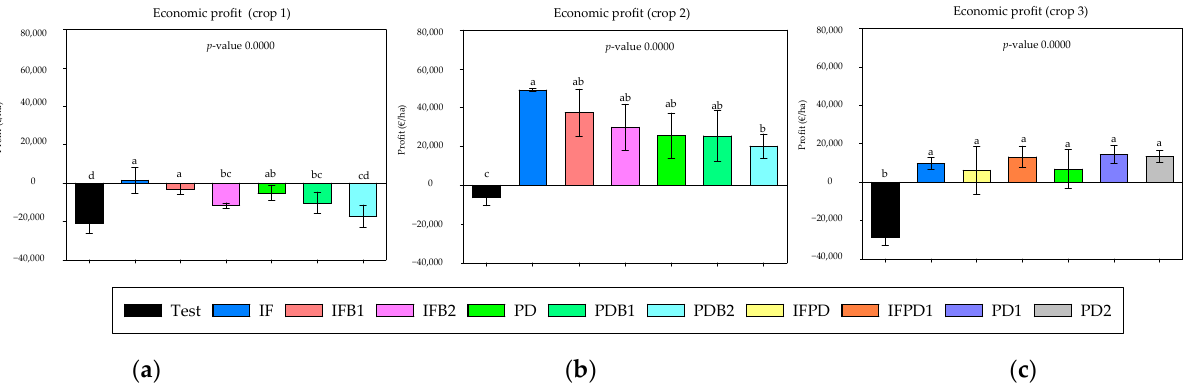
Figure 5. Pre-tax economic benefit in the three years of study in September–April tomato cycles as a function of crop nutrition: ( a ) Crop 1; ( b ): Crop 2; ( c ): Crop 3. Values (mean ± standard deviation). Different letters indicate significant differences ( p ≤ 0.05, Tukey’s HDS test). No fertilization (test); inorganic fertilization (IF); inorganic fertilization + 0.5 kg·m −2 of Brassica carinata pellets (IFB1); inorganic fertilization + 1.0 kg·m −2 of Brassica carinata pellets (IFB2); 3.5 kg·m −2 of tomato plant debris (PD); 3.5 kg·m −2 of tomato plant debris + 0.5 kg·m −2 of Brassica carinata pellets (PDB1); 3.5 kg·m −2 of tomato plant debris + 1.0 kg·m −2 of Brassica carinata pellets (PDB2); inorganic fertilization + 3.5 kg·m −2 of tomato plant debris (IFPD); inorganic fertilization + 5 kg·m −2 of tomato plant debris (IFPD1); 5 kg·m −2 of tomato plant debris (PD1); 6.5 kg·m −2 of tomato plant debris (PD2). Source: own elaboration based on Torresano and Camacho-Ferre [47], Honore et al. [2], Junta de Andalucia [48], Torres-Nieto